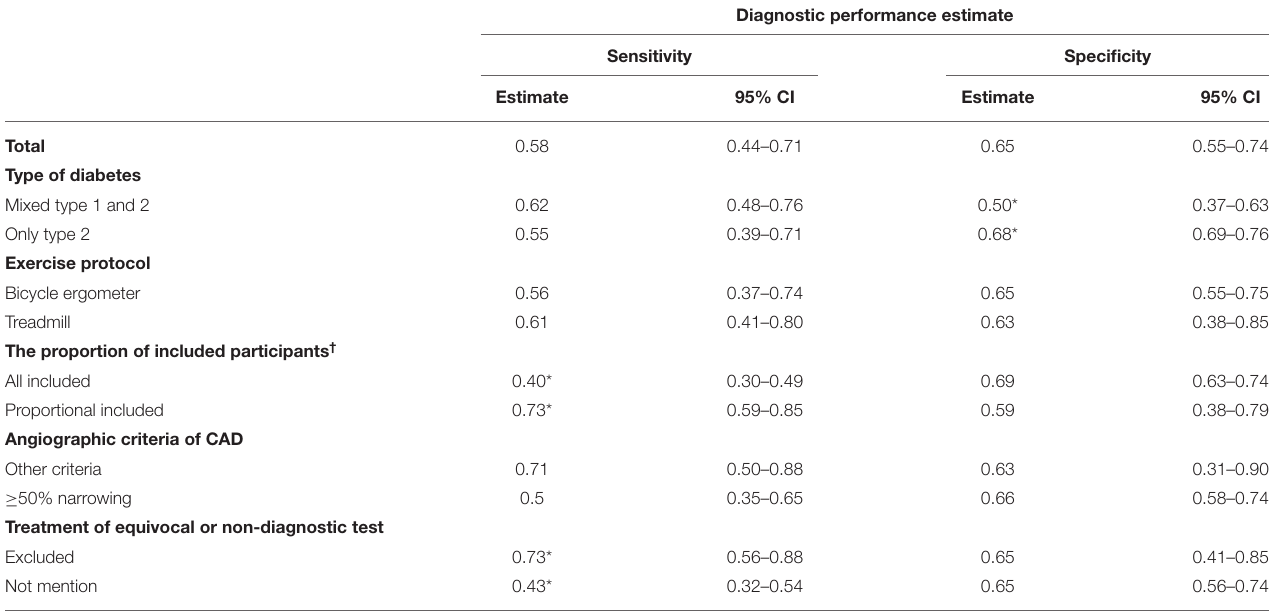
TABLE 4 | Sensitivity and specificity of EST for coronary artery disease according to total population and